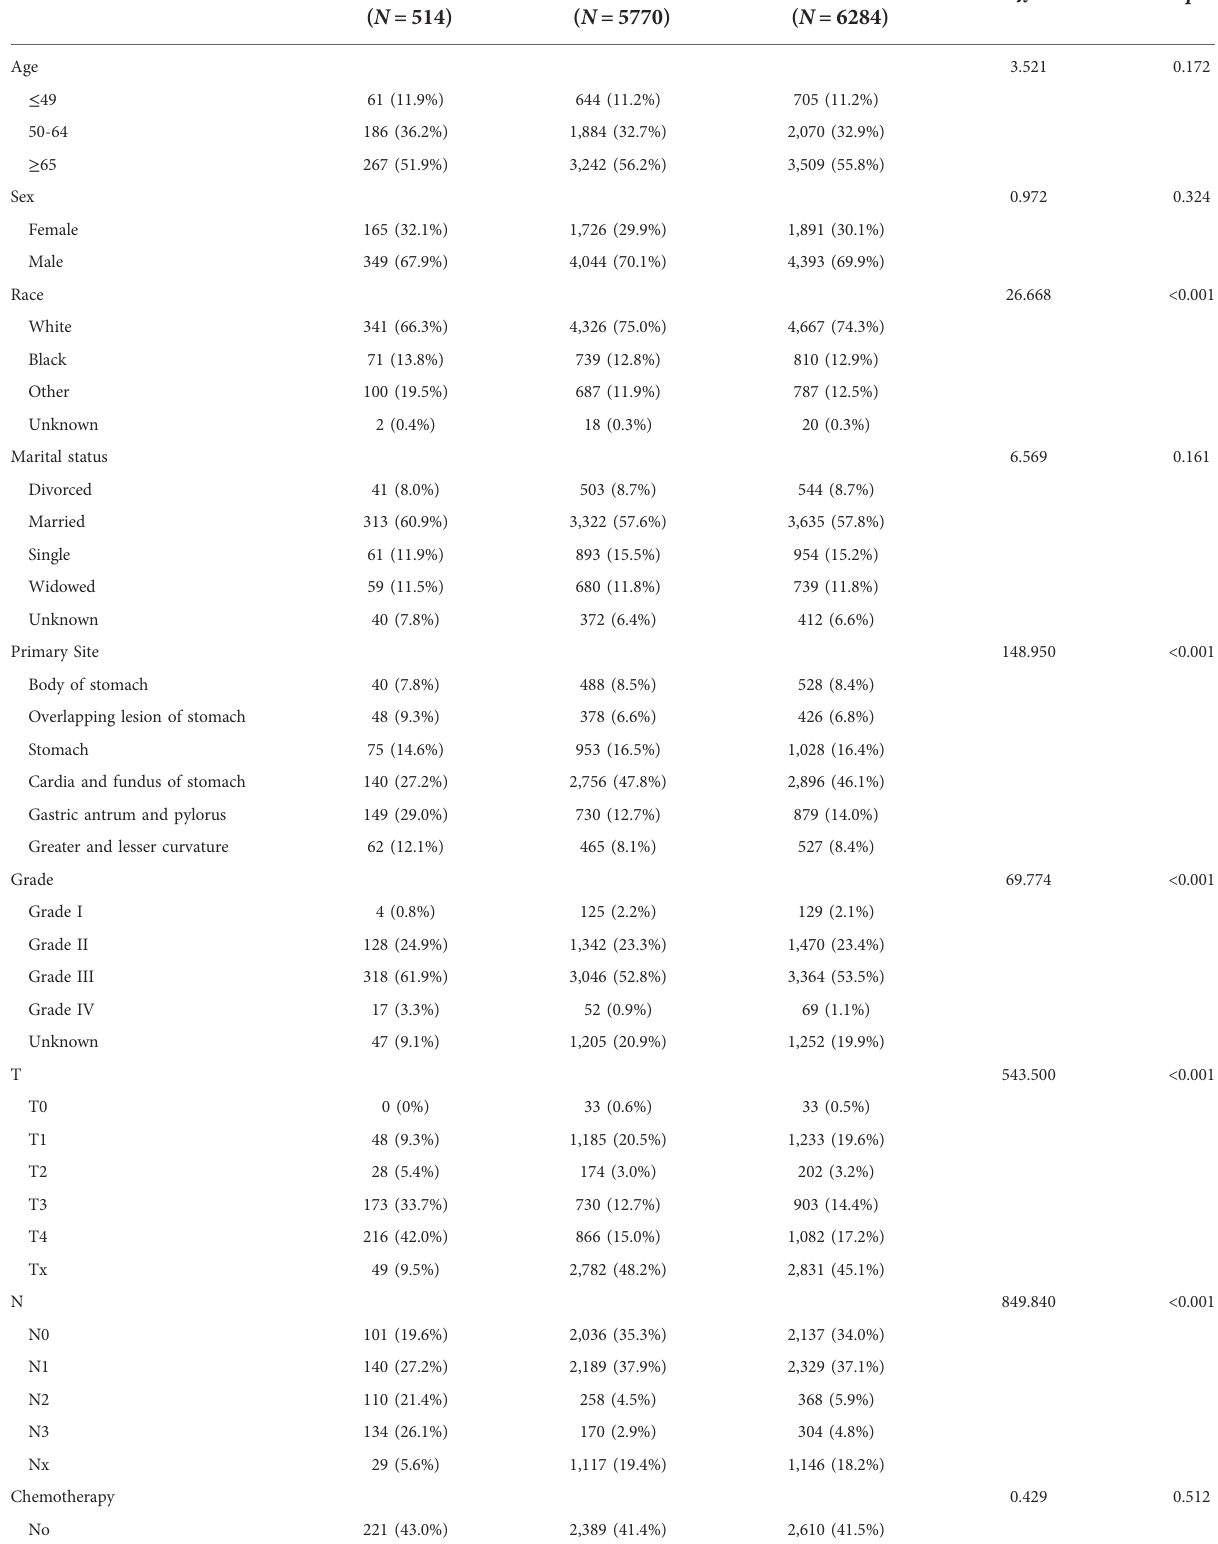
TABLE 1 Baseline characteristics before propensity matching scores, showing statistical comparisons between the CDS and no-CDS